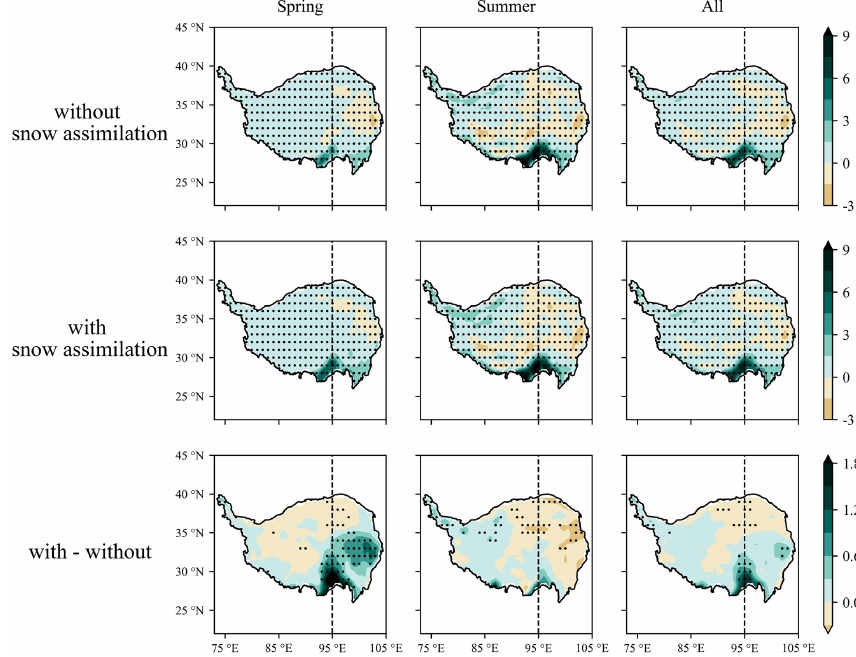
Figure 13. The spatial differences in total daily precipitation (mm) between the ensemble reforecasts and GPM data (top and middle rows) and between the two reforecasts (bottom row). The stippled regions show the statistical significance of the differences identified by the t test at a 5% significance